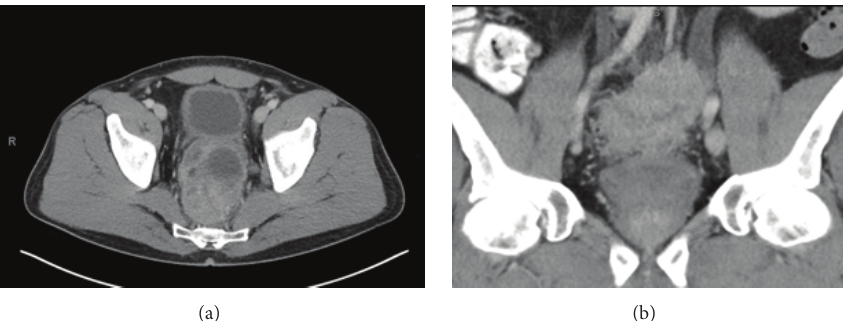
Figure 1: CT imaging of pelvis: (a) axial images showing large mass posterior to the bladder with areas of necrosis; (b) sagittal images with mass superior to bladder extending to involve the left ureter with proximal hydroureteronephrosis.